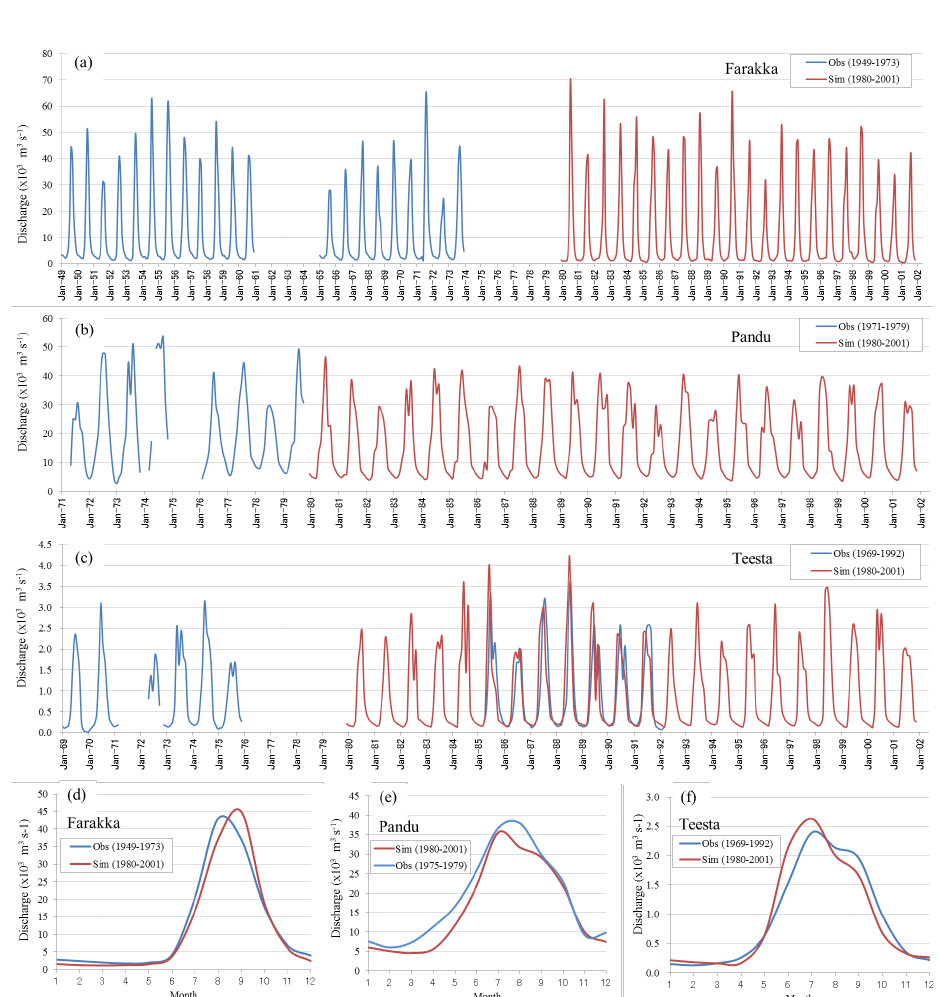
Figure A1. Comparisons between simulated (magenta line) and observed GRDC (blue line) data for (a) – (c) the monthly time series of discharges and (d) – (f) long-term mean seasonal cycles at the Farakka gauging station in the Ganges Basin and the Pundu and Teesta stations in the Brahmaputra